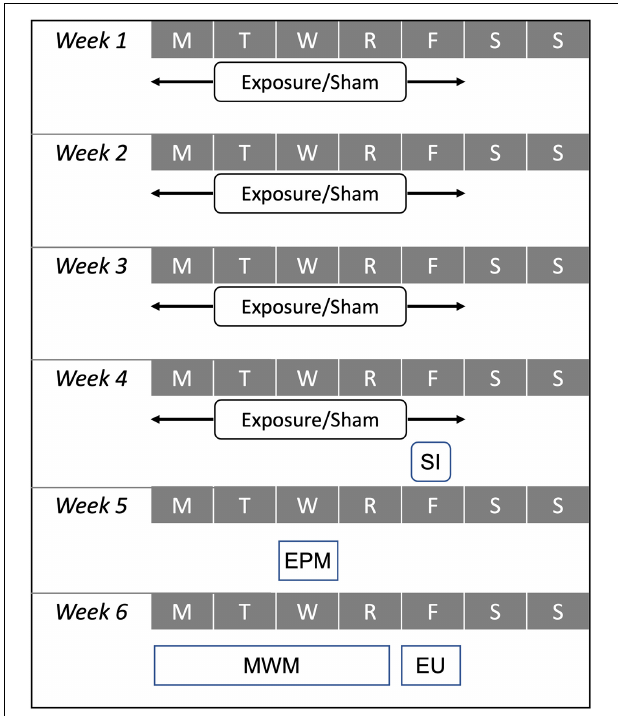
FIGURE 1 | Experimental test matrix demonstrating relative timing for the 4-week exposure protocol used for high exposure (30 accelerations/day) and moderate exposure (eight accelerations per day) groups, the sham protocol, and the single injury (SI) exposure during the first 4 weeks of the protocol. Behavioral assessments including the elevated plus maze (EPM) and Morris water maze (MWM) were conducted during the fifth and sixth weeks of the protocol. All animals were euthanized (EU) on Friday of the sixth week of the